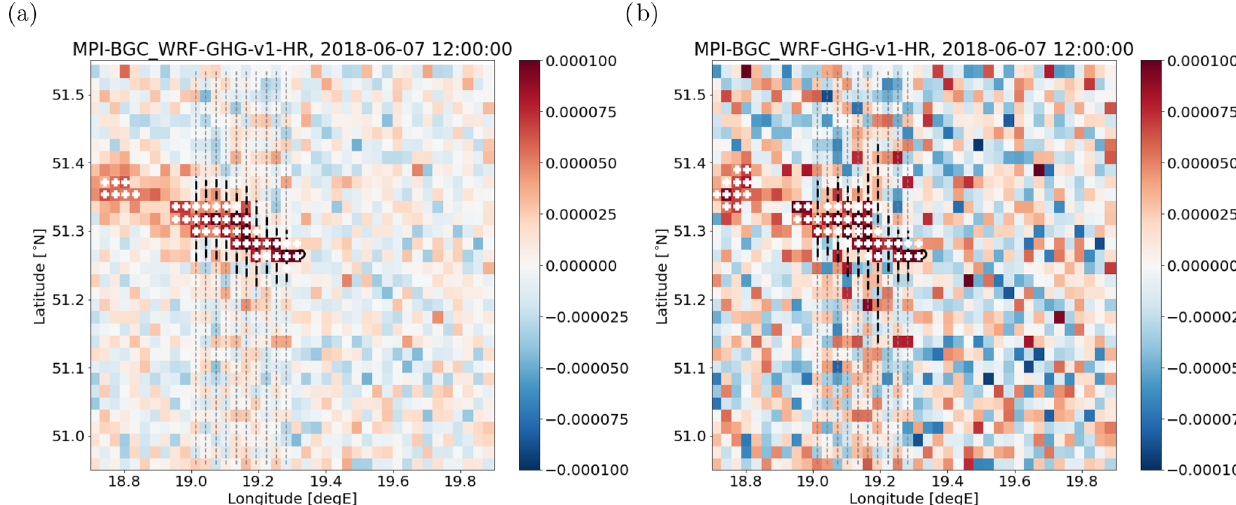
Figure 14. Illustration of cross-sectional flux and IME methods for the Bełchatów CO 2 plume (molcm − 2 ) on 7 June 2018 12:00UTC, as simulated by the WRF-GHG high-resolution (HR) model downsampled to 2km × 2km resolution for a (a) low-noise (0.5ppm) and (b) high- noise (1ppm) CO2M instrument noise scenario. For the IME method, pixels above a threshold of 0.4molm − 2 are marked as white crosses. For the cross-sectional flux method, fluxes through 10 north–south cross sections (thin dashed gray lines) downwind of the power plant were computed and averaged. The centers and north–south extensions ( ± 2 σ ) of the plumes, as determined by a Gaussian plume fit, are marked with black circles and thick dashed black lines,